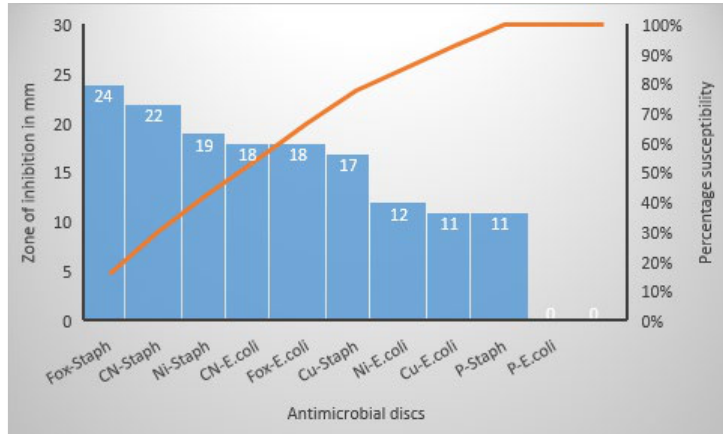
Fig. 10. Lawn culture of E. coli indicating zone of inhibition around NiO nanoparticle coated discs and